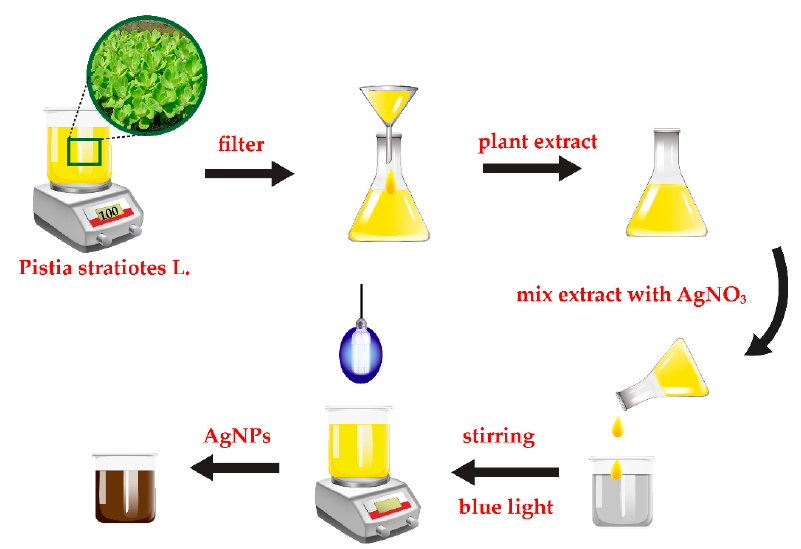
Figure 1. Schematic diagram of silver nanoparticles (AgNPs) synthesis based on a green route method.